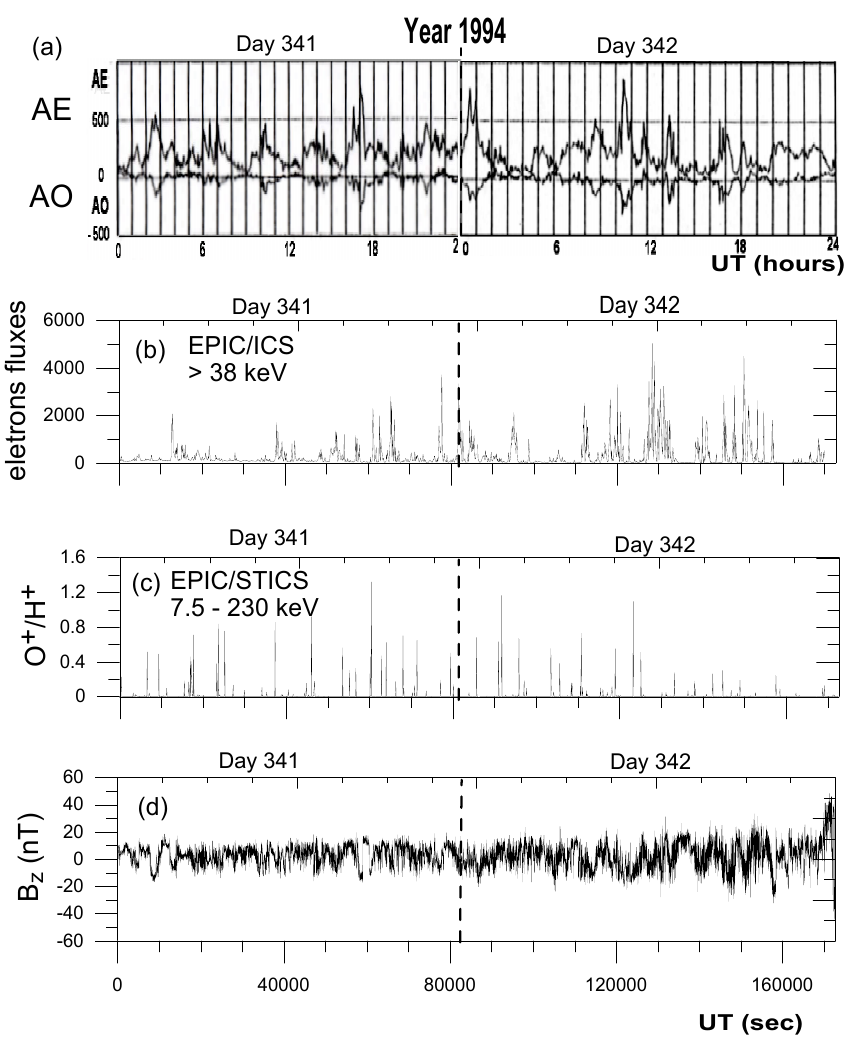
Figure 6 Fig. 6. From top to bottom, (a) AE index measurements with one minute resolution, (b) the energetic > 38keV electrons (second panel),